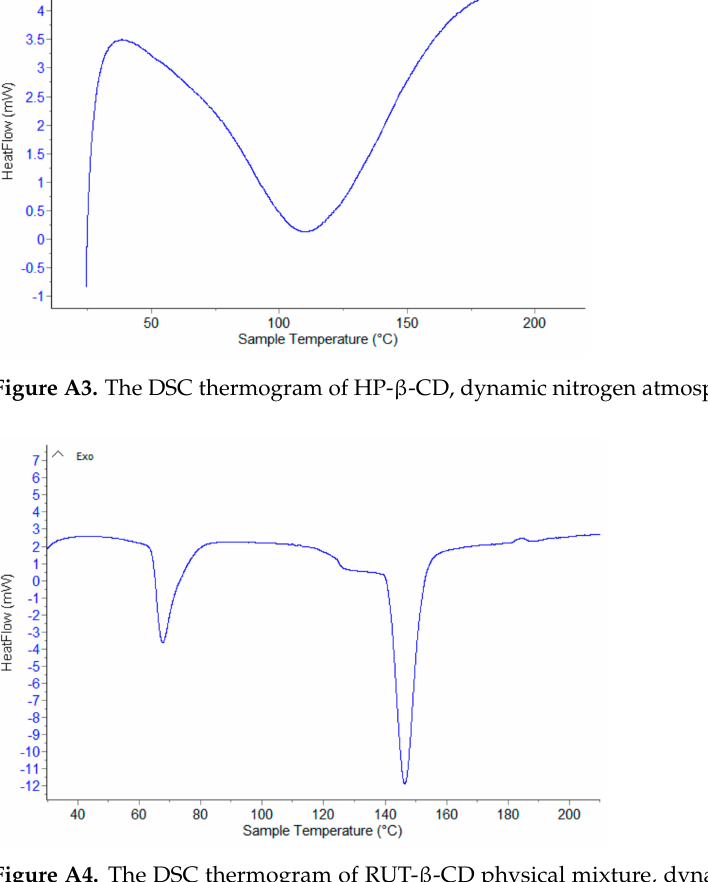
Figure A4. The DSC thermogram of RUT- β -CD physical mixture, dynamic nitrogen atmosphere, β = 10 K min − 1